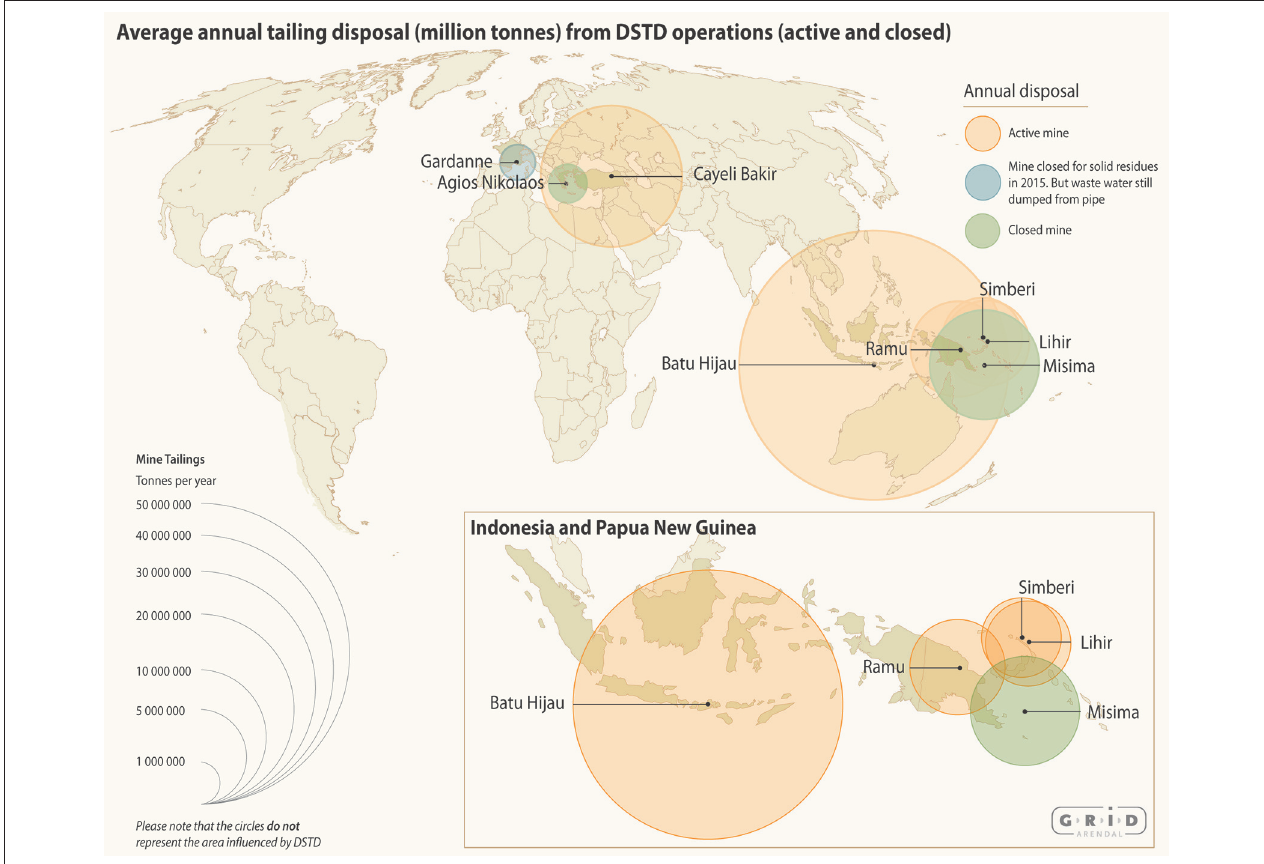
FIGURE 1 | Average annual tailing disposal (million tons) from DSTD operations (active and